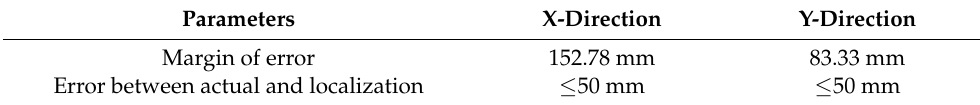
Figure 27. Absolute error in the x-direction and y-direction before and after distortion correction. Due to the inaccurate localization of the sampling robot in the sampling process, resulting in sampling points being identified beyond the sampling area, according to the sampling point error range requirements, the randomly generated sampling points have a 152.78 mm error margin in the x-direction and an 83.33 mm error margin in the y-direction from the boundary of the sampling area, as shown in Table 8. Table 8. X-direction and y-direction localization error range requirements.